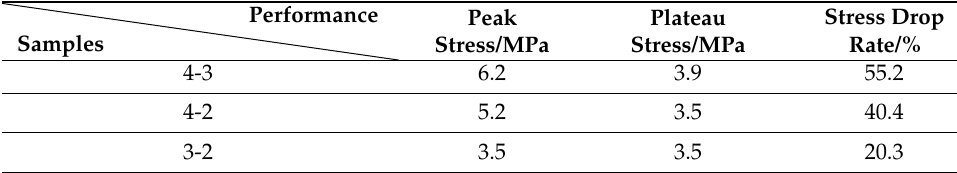
Figure 4. The compressive curves of two-layered structure Al foams with different cell-size gradients (4-3, 4-2, 3-2). Table 1. The mechanical properties of the samples with different cell sizes.